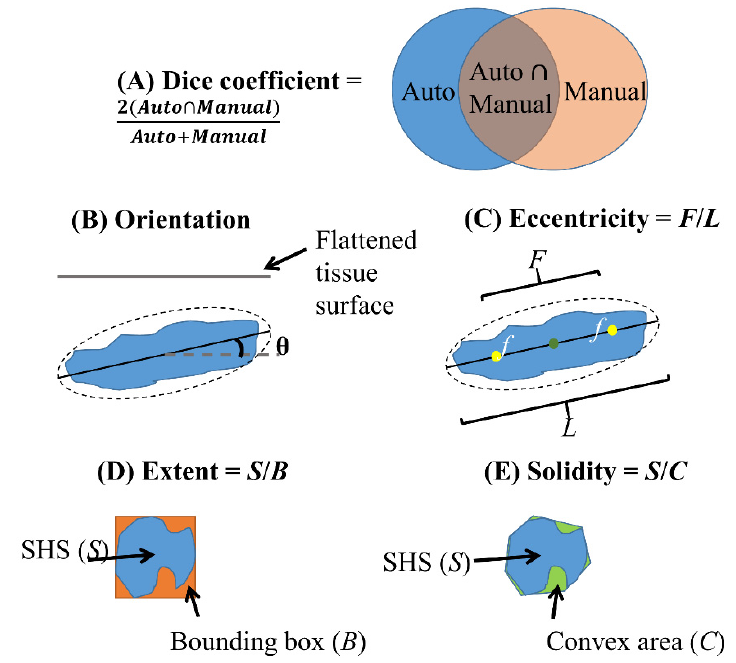
Figure 2. Illustration of Dice coefficient ( A ) for validation of SHS boundary segmentation and quantitative shape descriptors ( B – E ) used in this study. ( B ) Orientation is the angle between the flattened tissue surface and the major axis of the ellipse fit to the SHS. ( C ) Eccentricity is the ratio of the distance between the foci (f) of the ellipse and its major axis length. ( D ) Extent is the ratio of area between the SHS and its bounding box. ( E ) Solidity is the ratio of area between the SHS and its convex hull.